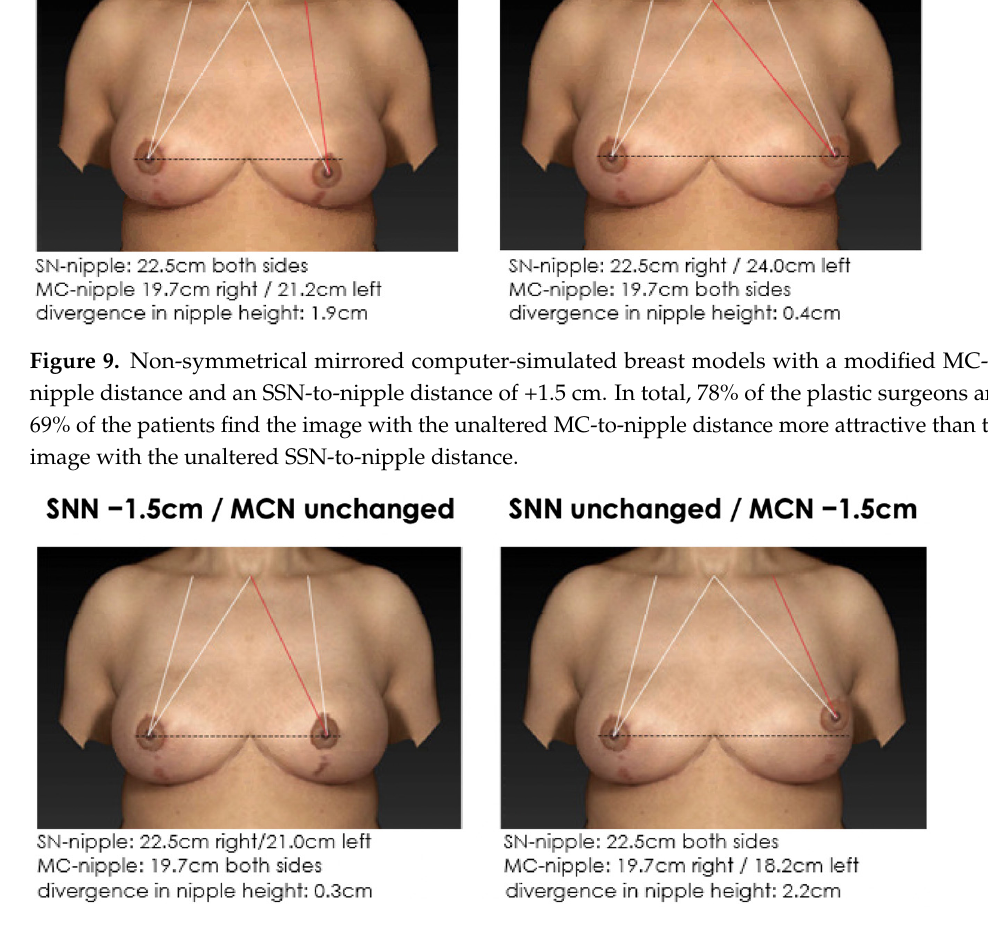
Figure 10. Non-symmetrical mirrored computer-simulated breast models with a modified MC-to- nipple distance and an SSN-to-nipple distance of − 1.5 cm. In total, 94% of the plastic surgeons and 96% of the patients find the image with the unaltered MC-to-nipple distance more attractive than the image with the unaltered SSN-to-nipple distance.